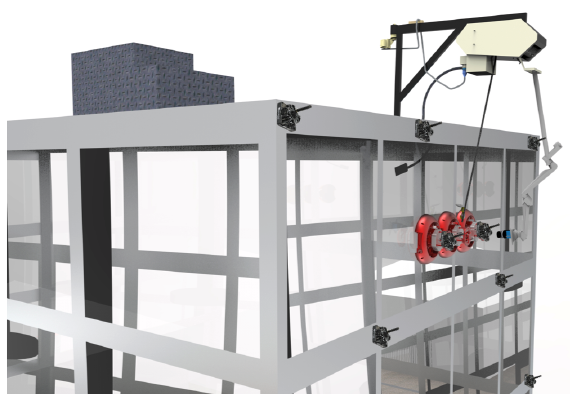
Figure 9. Beacon navigation system terminals on the glass façade structure of a building, in strategic corners of the